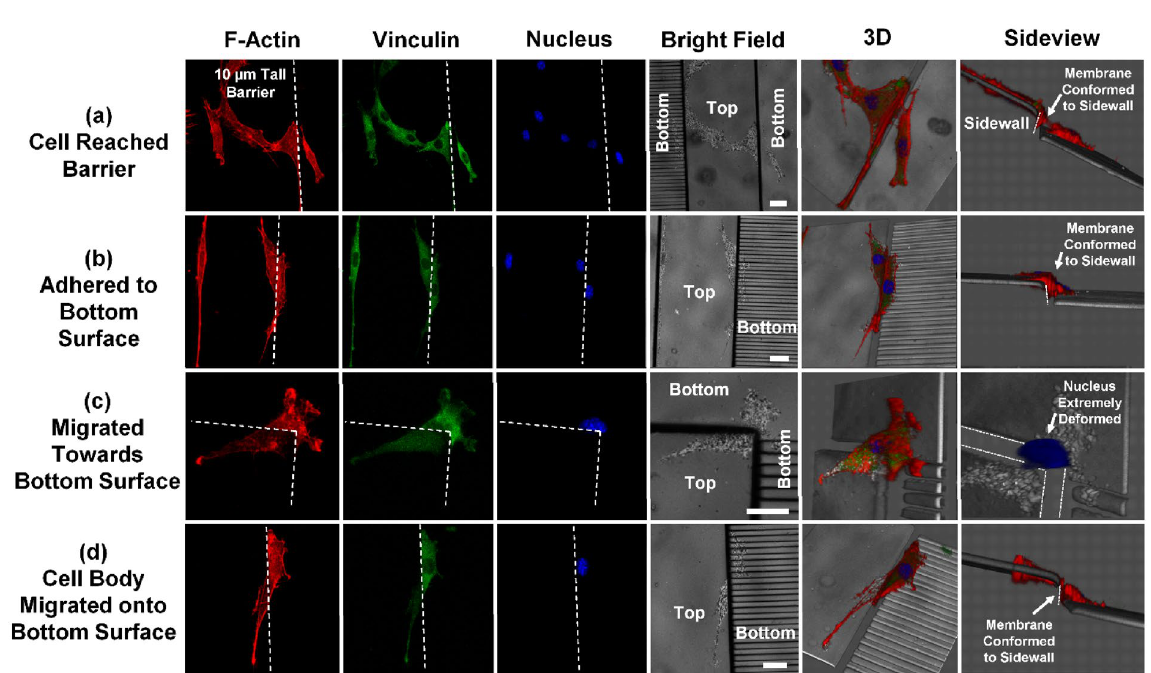
Figure 8. Immunofluorescence micrographs of MC3T3 cells moving down 10 µm tall barriers. Red: F-actin; green: vinculin; blue: nucleus; grey: reflected bright field. ( a ) MC3T3 cell on top surface reached barrier and adhered to sidewall. ( b ) Cell migrated down barrier with cell membrane conformed to sidewall. ( c ) Cells migrated towards bottom surface. Cell nucleus conformed to barrier sidewall and was extremely deformed. ( d ) Cell body moved onto bottom surface. Trailing edge still conformed to sidewall of barrier. All scale bars in the micrographs are 20